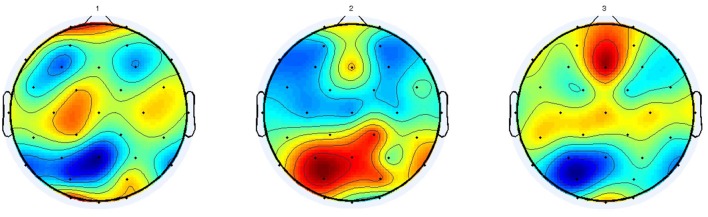
The average forward model of the spatial components used in calculating Cognitive-congruency scores.